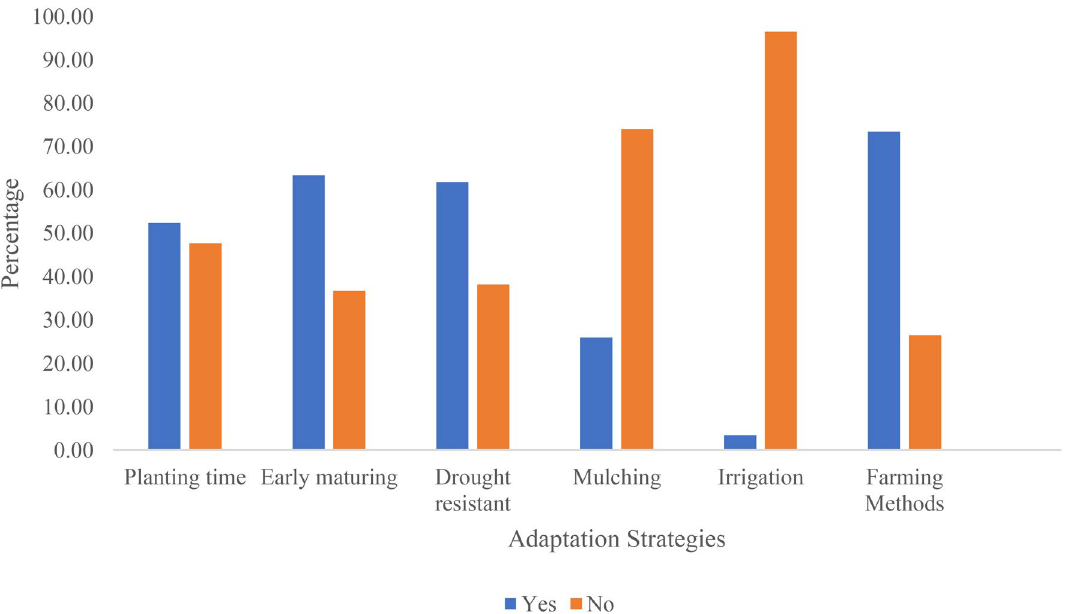
Fig. 2 Summaries of the choice of adaptation strategies to climate change in